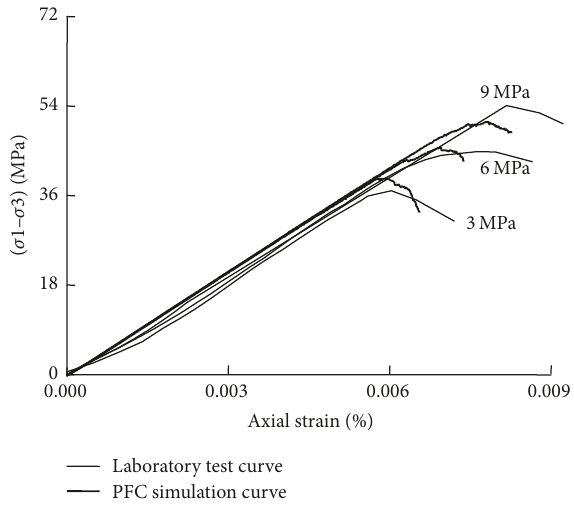
Figure 4: Stress-strain curves at different confining stresses.